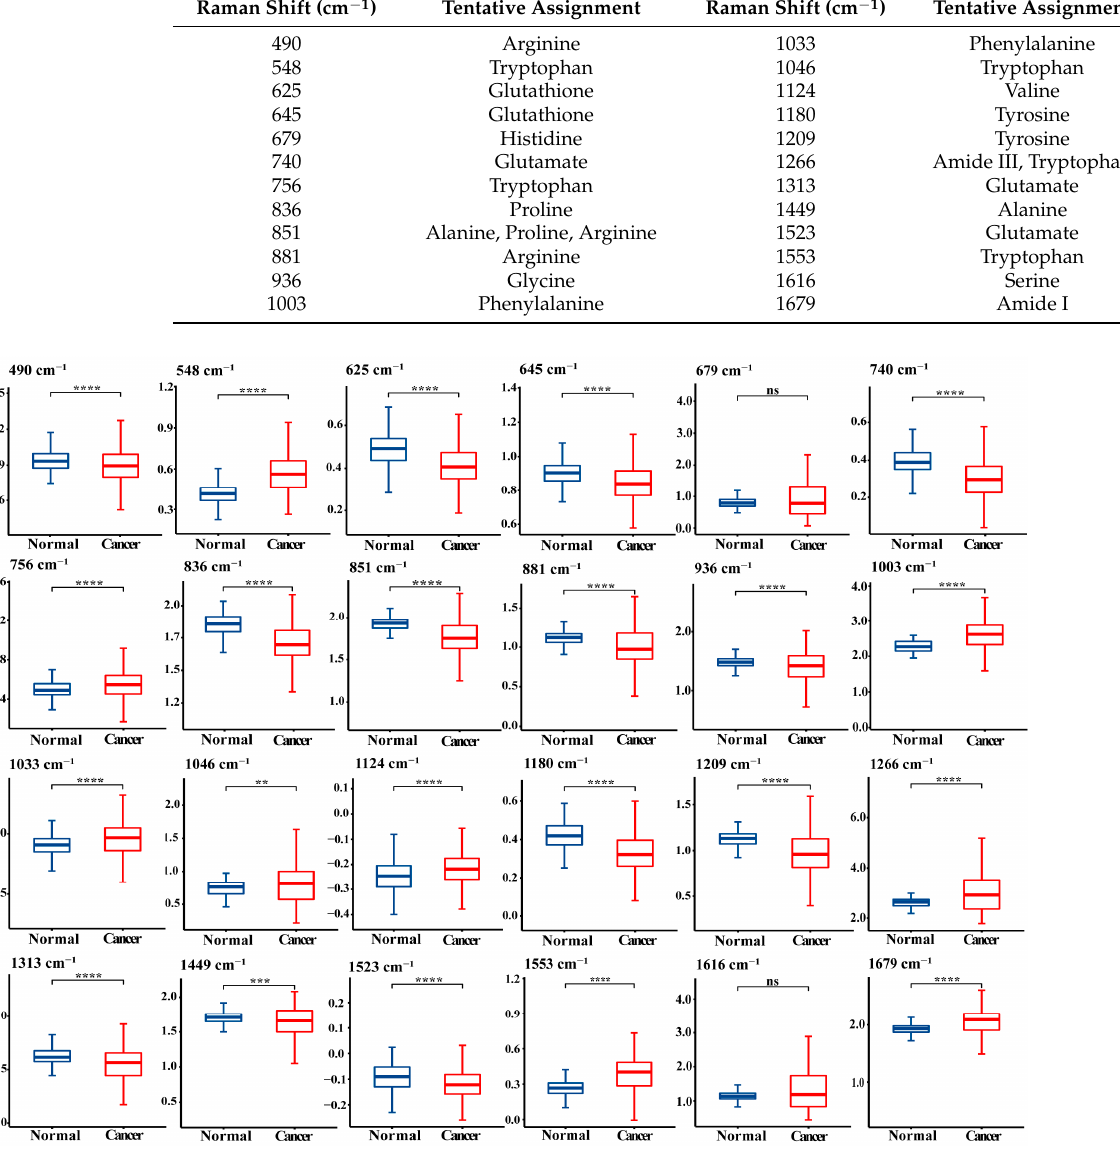
Table 2. Tentative protein assignments for the SERS spectra.